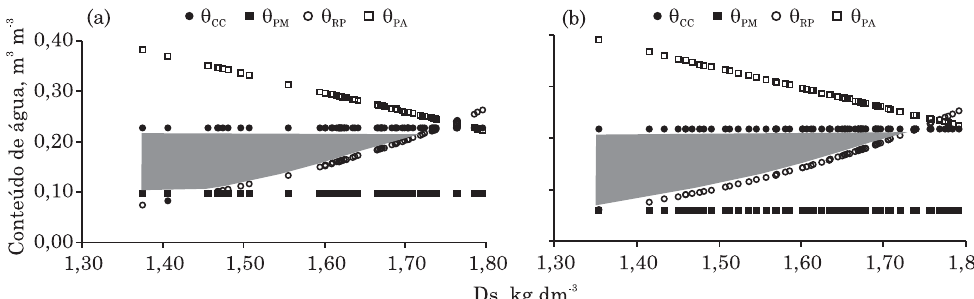
Figura 4. Variação dos conteúdos de água do solo na capacidade de campo (  CC ), ponto de murcha permanente (  PMP ), porosidade de aeração de 10 % (  PA ) e resistência do solo à penetração de 2,0 MPa (  RP ), em função da densidade do solo para as estratégias USUAL (a) e CAMPO (b). A área hachurada corresponde ao intervalo hídrico ótimo do